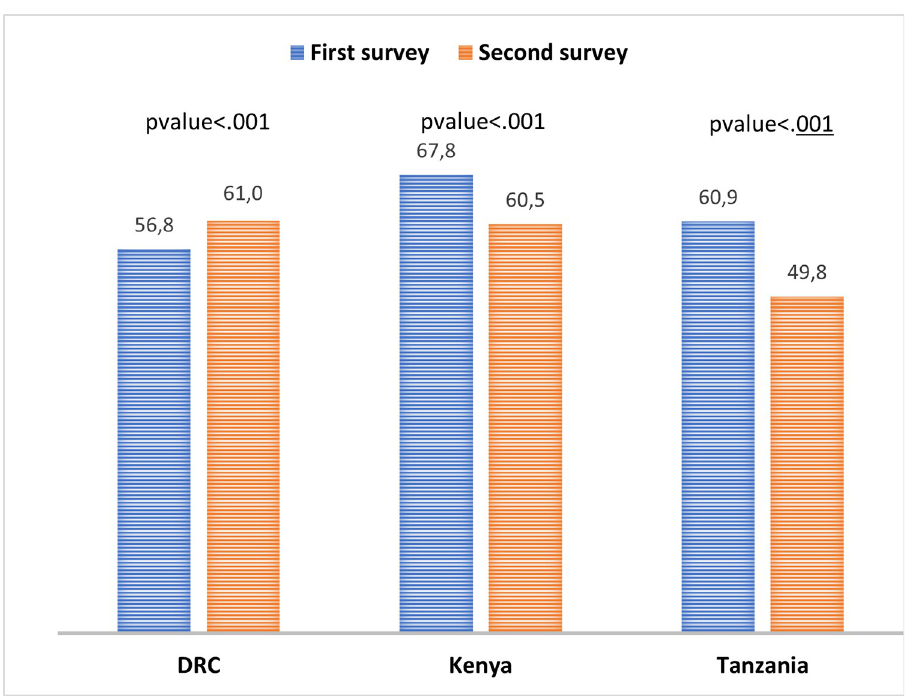
Fig 3. Trends of late ANC initiation in the DRC, Kenya, and Tanzania between the first and second surveys.